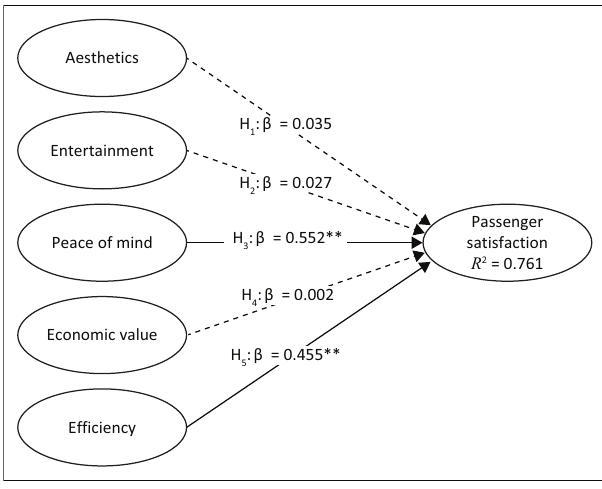
FIGURE 2: Final model